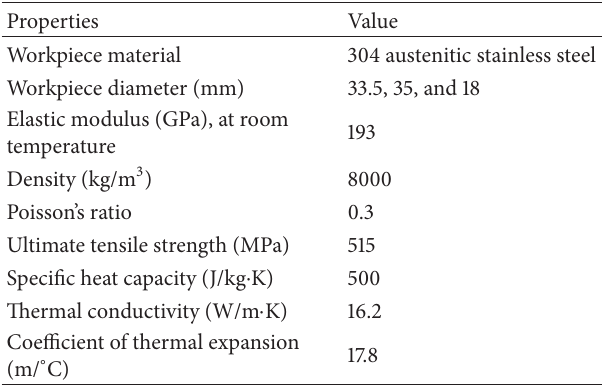
Table 1: Physical and mechanical properties of workpiece